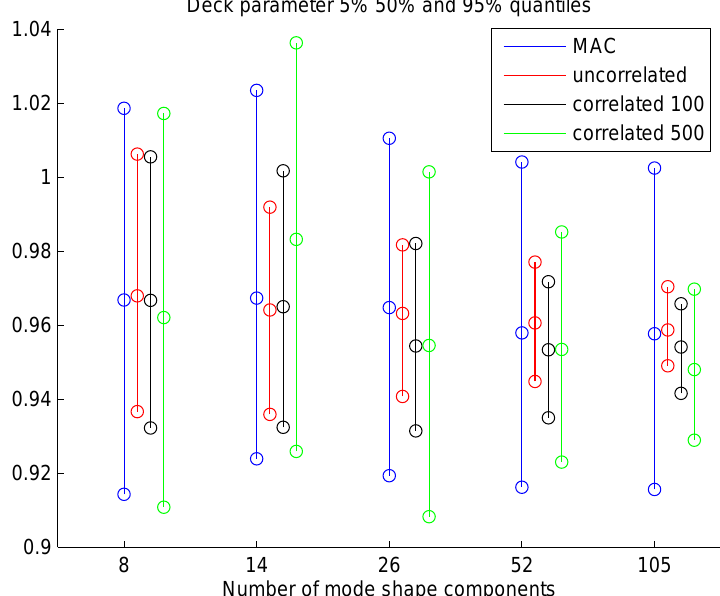
Figure 7. Deck parameter posterior uncertainty versus number of sensors. The MAC case corresponds to the MAC-based likelihood formulation, while “uncorrelated”, “correlated 100” and “correlated 200” cases correspond to vector-based likelihood formulations with exponential spatially correlated prediction error given by Equation (8) with λ r = 0, 100 and 200 respectively.